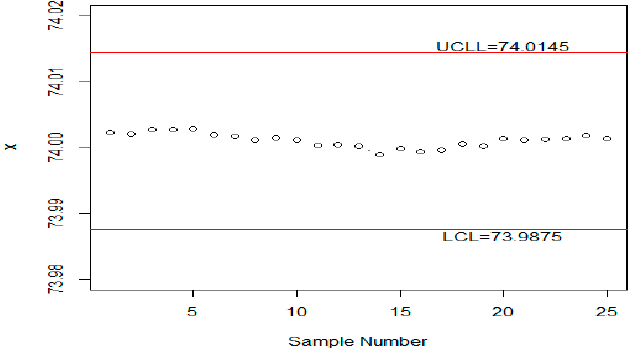
Figure 5. The Aslam and Khan (2019) chart for the real data.